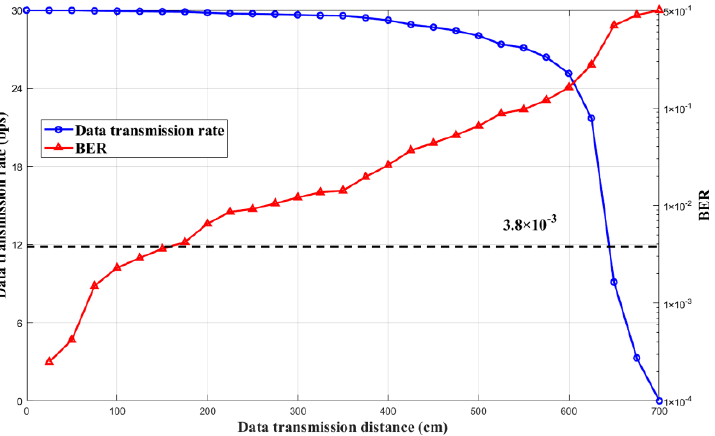
Figure 6. The data transmission performance of the proposed LED-DCC system.